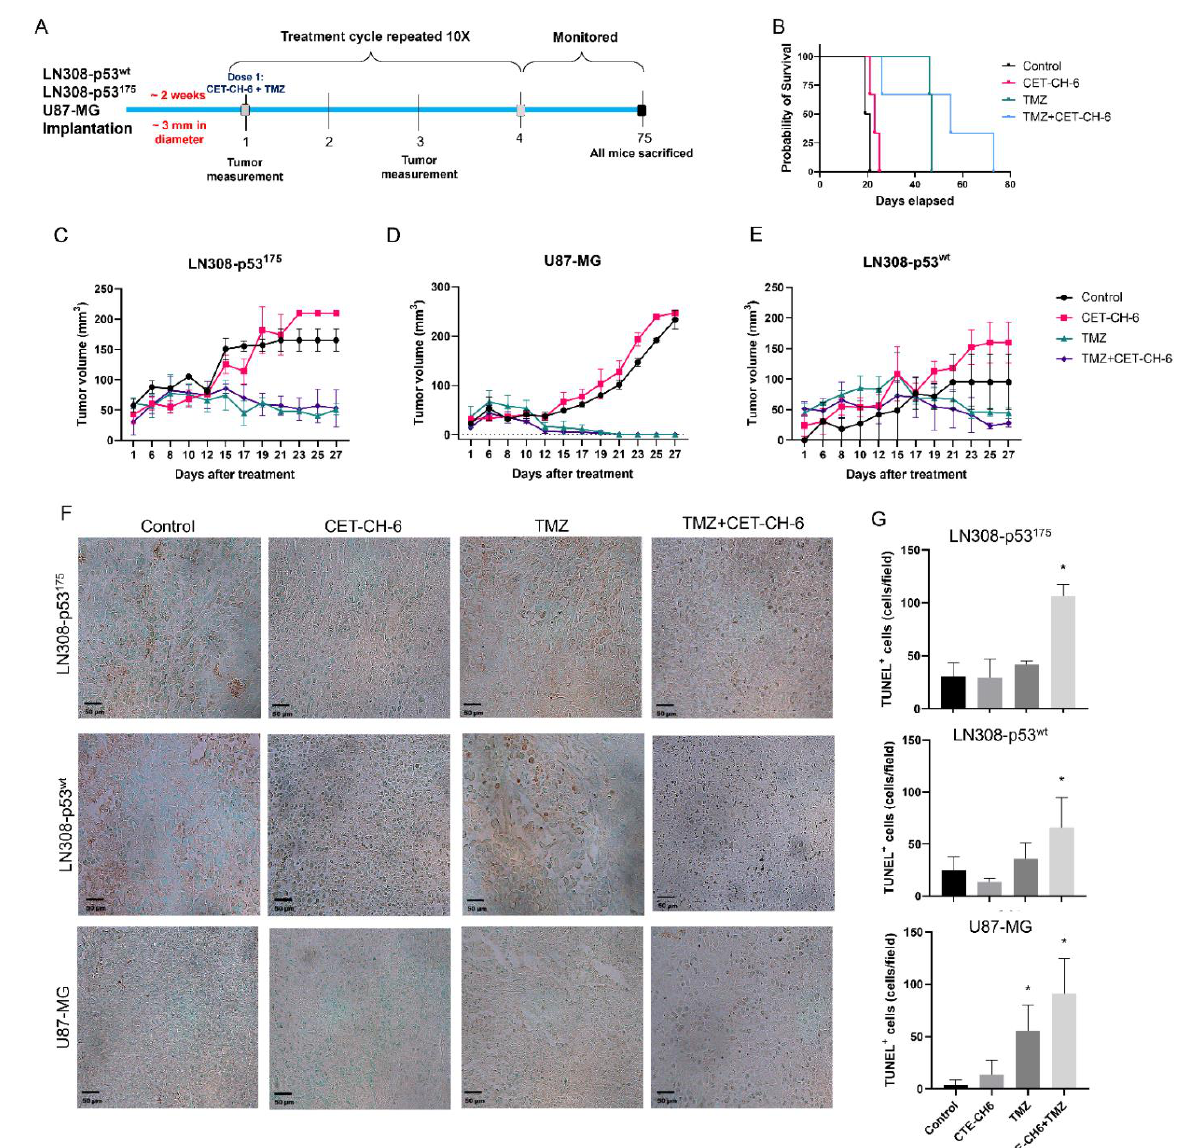
Figure 8. In vivo evaluation of CET-CH-6 in combination with TMZ on NSG mice bearing LN308-p53 175 , LN308-p53 wt , and U87-MG cells. ( A ) Schematic workflow of in vivo treatment. Mice (N = 4–6/group) were implanted subcutaneously into the left and right flank, respectively. When the tumors reached 3 mm/diameter, the mice were randomized into four groups: control, TMZ (12.5 mg/kg body weight), CET-CH-6 (2.5 mg/kg body weight), CET-CH-6 + TMZ (co-treated with 2.5 and 12.5 mg/kg body weight of CET-CH-6 and TMZ, respectively). The mice received i.p. doses of drugs every four days for ten cycles; ( B ) survival curve of mice with LN308-p53 175 tumors. Tumor volume measurements for each cell lines over time: ( C ) LN308-p53 175 ; ( D ) U87-MG; ( E ) LN308-p53 wt ; ( F ) TUNEL assay to show the apoptotic population in tumor tissue; and ( G ) quantification of tunnel assay, each row shows one cell line. Error bars represent mean ± SD. * markers above the columns represent p -value <